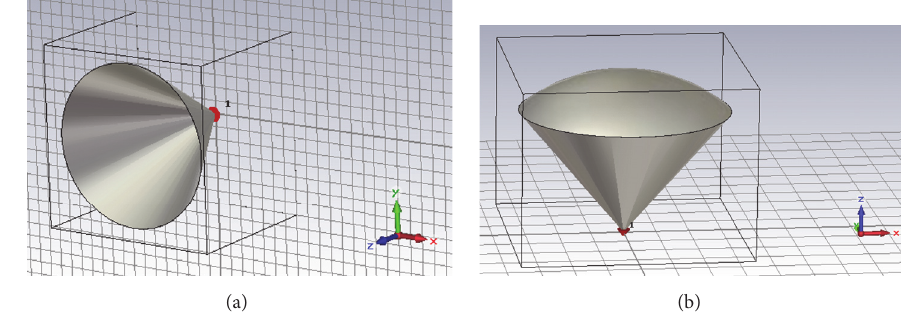
Figure 10: CST GUI views of the (a) OCA and (b) SCCA.